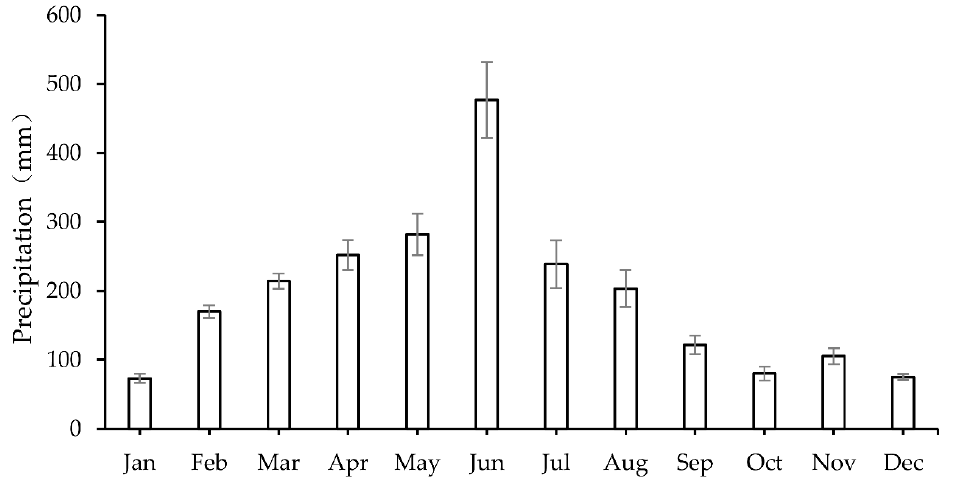
Figure A2. Mean monthly precipitation in the Shuaishui River Basin: 2009–2017. The error bar shows ± one standard deviation of the monthly average precipitation among the 13 stations.